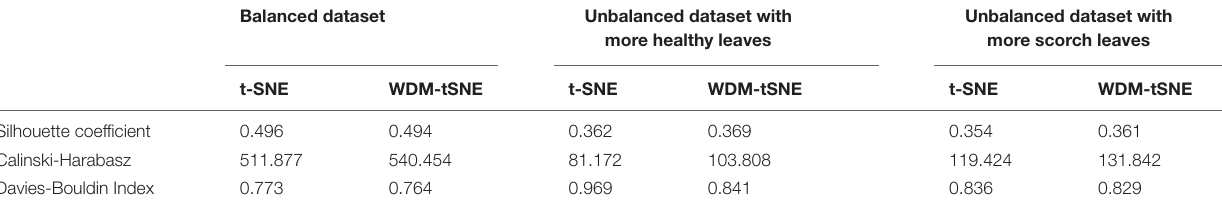
TABLE 2 | The performance of WDM-tSNE on the multiple datasets of cherry. Balanced dataset Unbalanced dataset with more healthy leaves